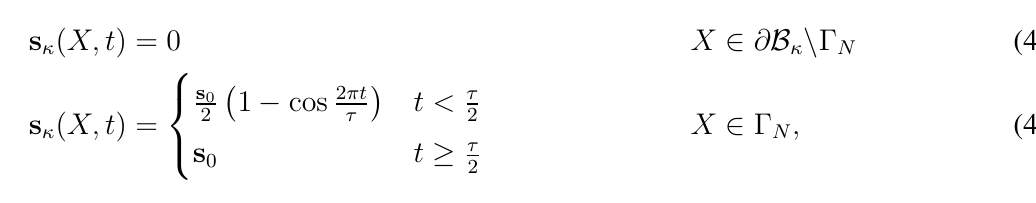
Figure 9 . Geometry and initial meshes for the simulations of an idealized 2D compact test specimen. Vertical traction loading is applied to the faces denoted as Γ N , creating a situation likely to result in Figure 1. Algorithm flow chart Mode I failure. The meshes were created using the pave (left) and submap (right) methods in Cubit [17].